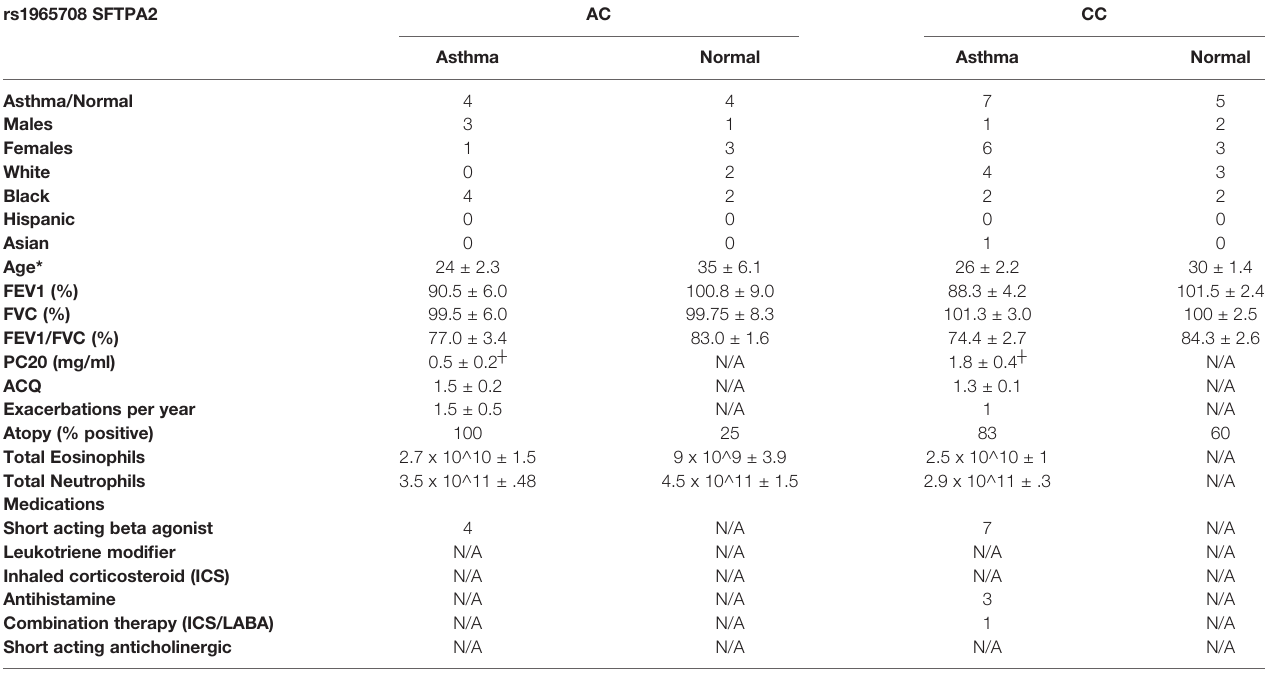
TABLE 2 | Demographics for patients that underwent bronchoscopy for analysis of bronchial epithelial cells.